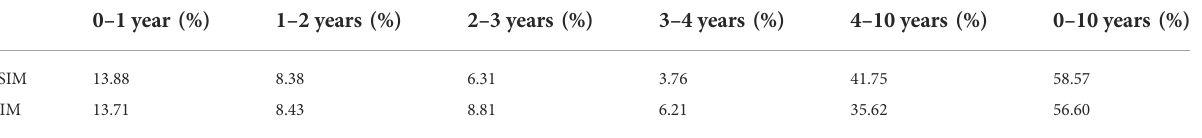
TABLE 3 Reservoir pressure decline rate with ASIM and